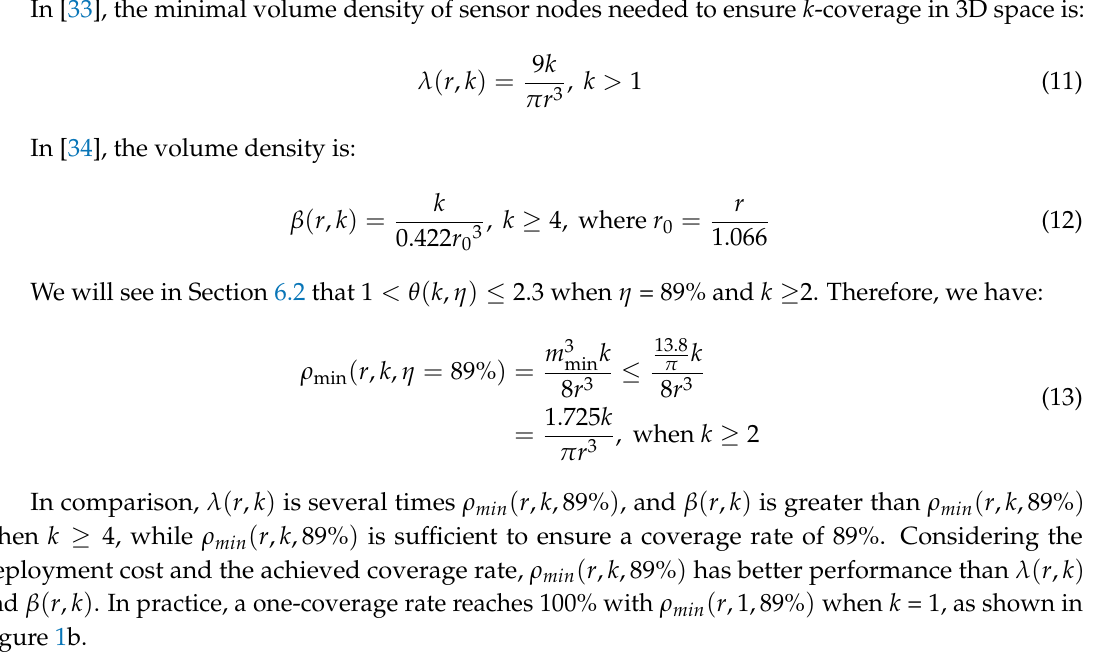
k 1 2 3 4 5 ... θ ( k , η ) 1 2 2 2 2.3 ... m min ( k , η ) ρ min ( r , k , η )